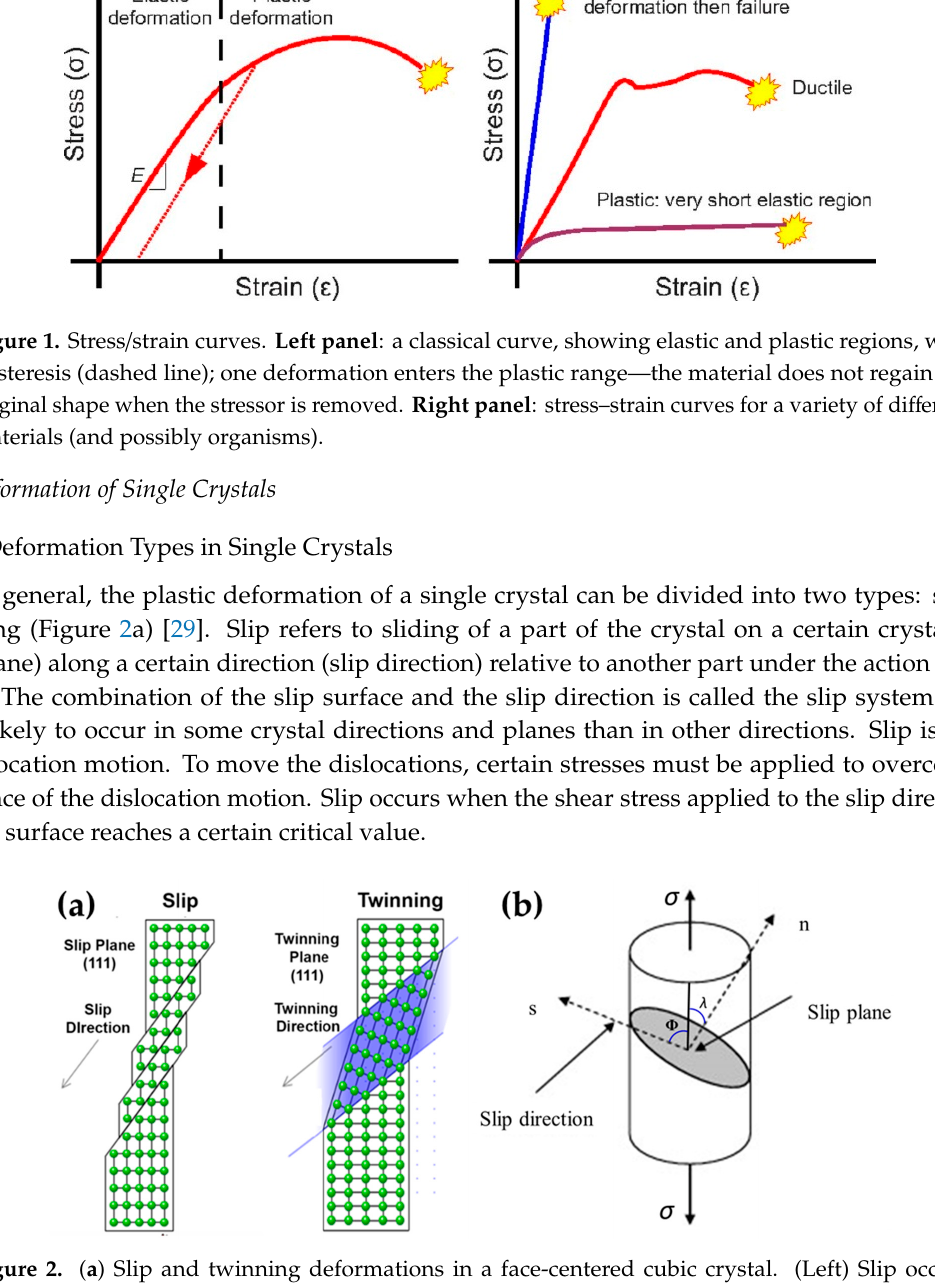
Figure 2. ( a ) Slip and twinning deformations in a face-centered cubic crystal. (Left) Slip occurs when dislocations glide through the material, causing crystal planes to slide along each other. (Right) Twinning occurs via a concerted shift of atomic positions in the twinning direction. The twin crystal’s structure is a mirror image of the parent structure about the twinning plane. ( b ) Where n is the normal vector to the slip plane and s is the slip